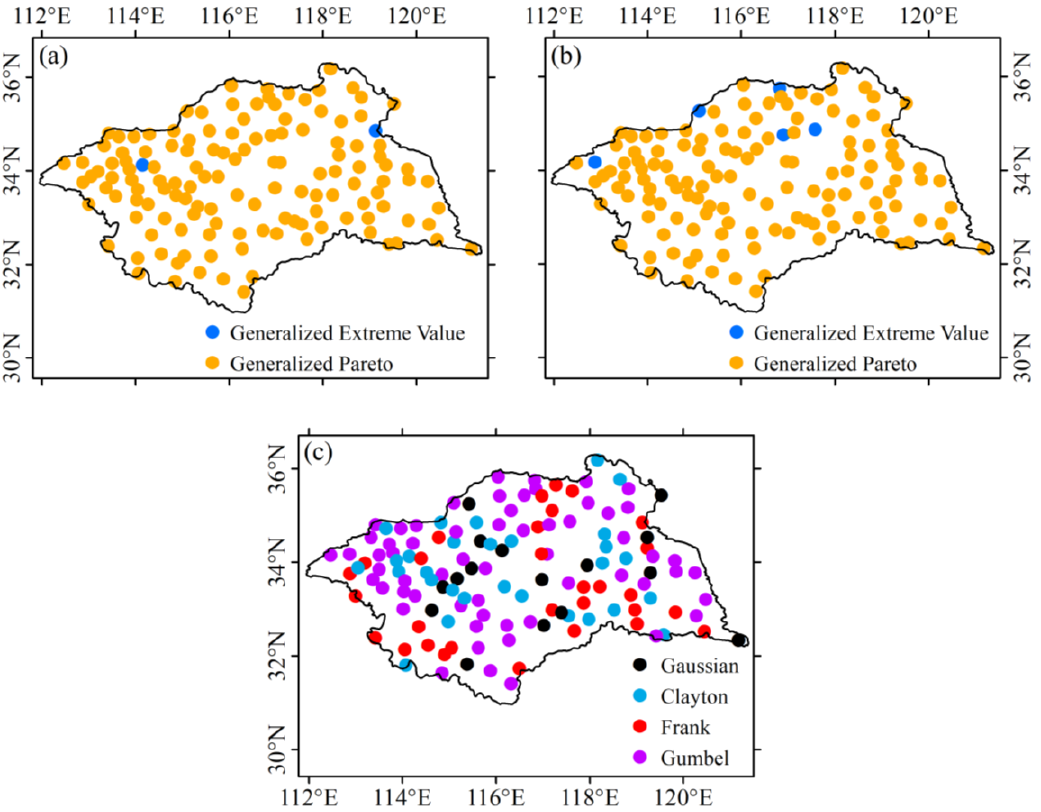
Figure 18. The selection of appropriate marginal distributions for ( a ) daytime and ( b ) nighttime precipitation under CEDNP conditions, and ( c ) their copulas.